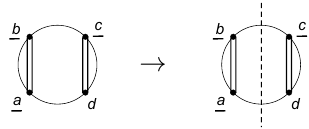
Figure 10 . Four-point diagrams with double pole and its factorisation